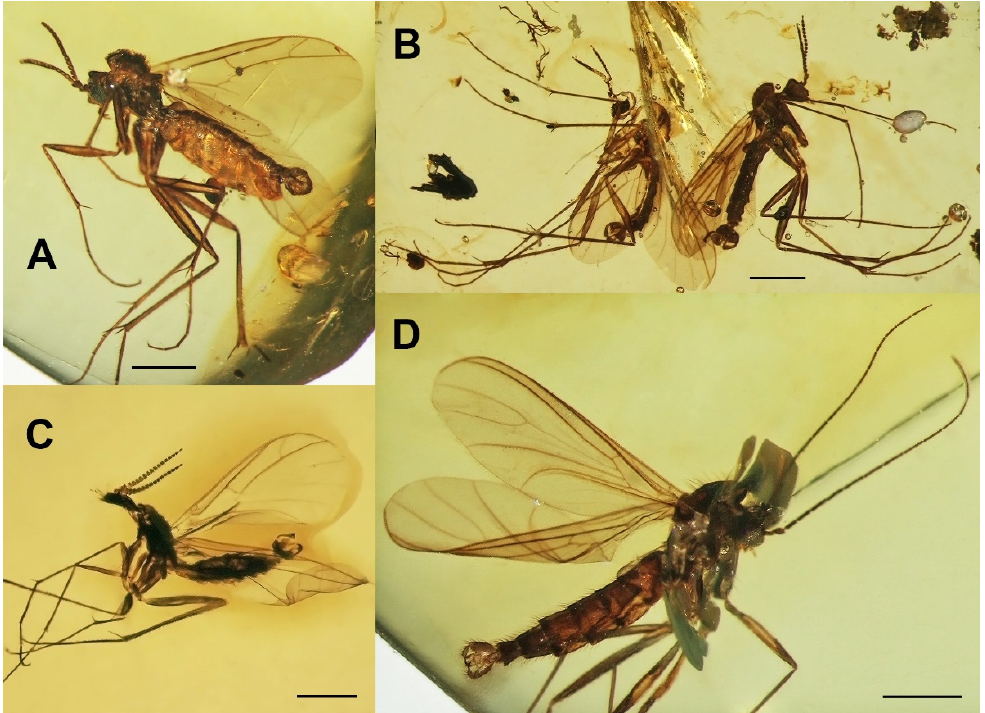
Figure 9. Habitus photographs of new fossil taxa. ( A ) Burmasymmerus korneliae gen. et sp. nov. (holotype, No. MP/4342); ( B , C ). Burmasymmerus wieslawi gen. et sp. nov. ( B ), holotype No. MP/4341/1 on the left and paratype No. MP/4341/2 on the right, in syninclusion, ( C ), paratype No. 154/2020; ( D ) Burmatricha mesozoica gen. et sp. nov. (holotype, No. 118/2020). Scale bars: 1 mm.